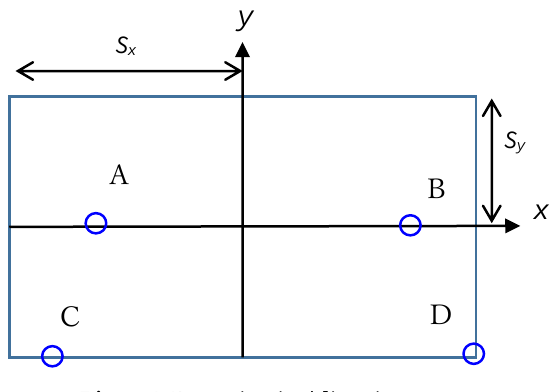
Figure 4 . Key points in oblique images. Let's assume that the ground coordinates of the imaging point O are ( X 0 , Y 0 , Z 0 ), ground coordinates of point P are ( X,Y,Z ), photo coordinates of the image point are ( x,y ), and focal length is f as shown in Fig. 5, the photo coordinates of the image point p can be calculated from the following collinearity condition equation.